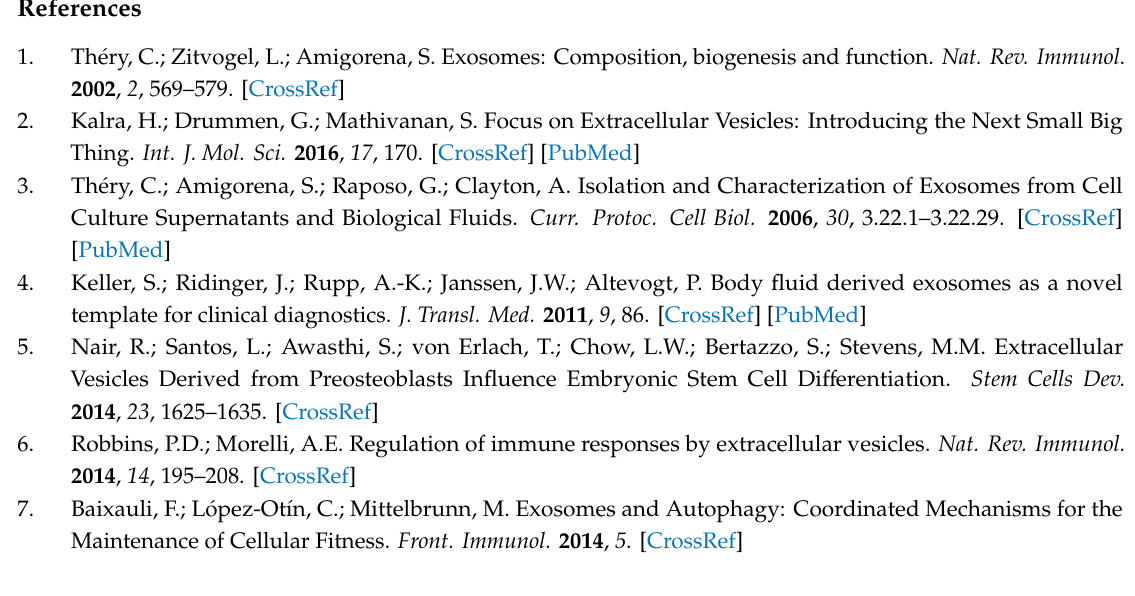
Supplementary Figure S2: comparison of mNeonGreen and eGFP